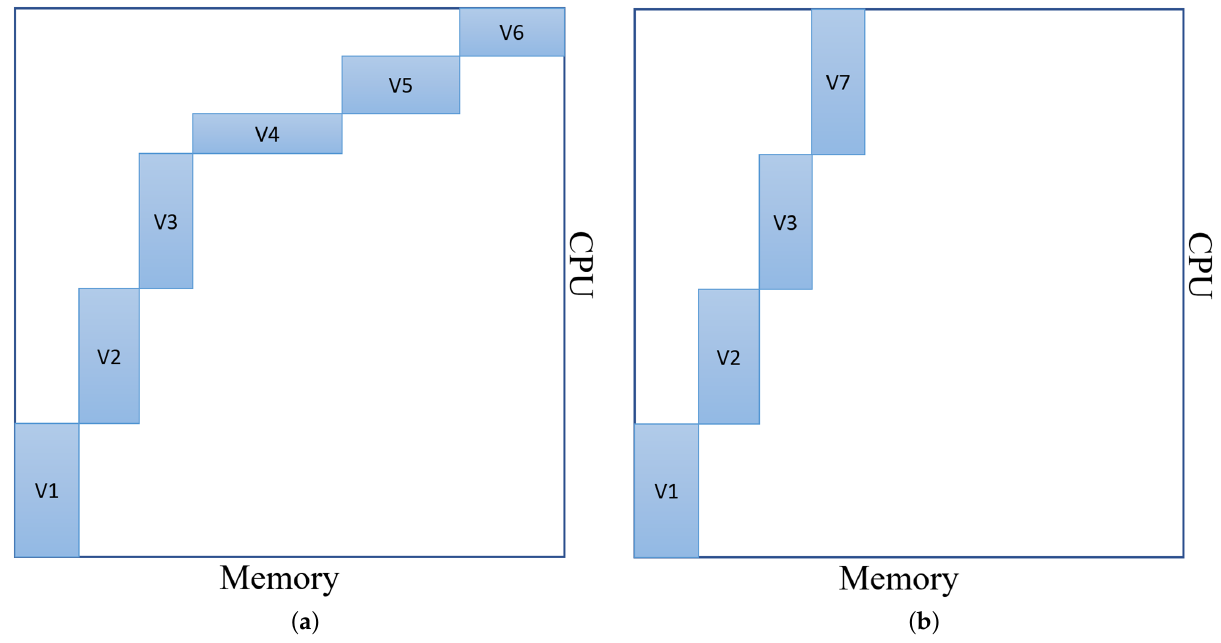
Figure 8. Example of VM placement on resource space competition. ( a ) VM placement 1; ( b ) VM placement